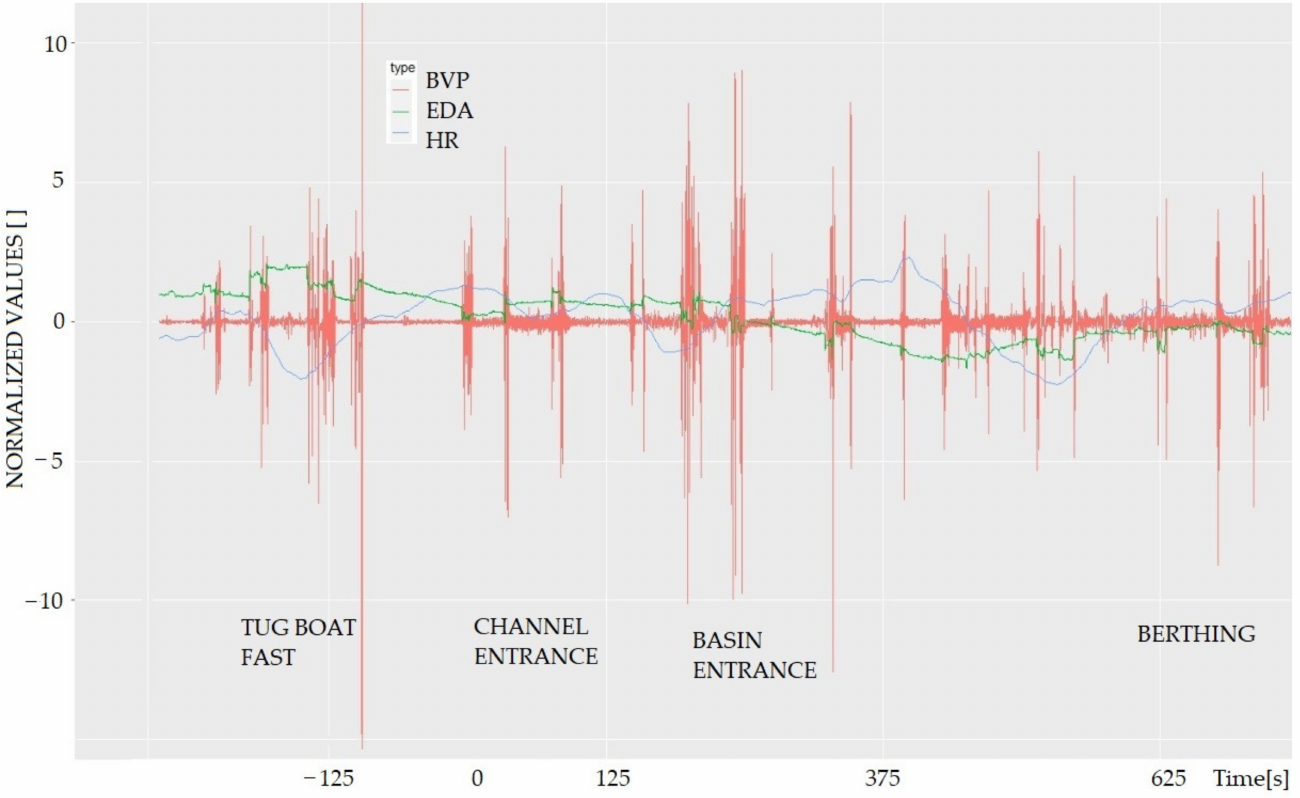
Figure 4. The normalized biometrical response of the experienced participant “1” during the port approaching task. The pattern is similar to all participants. The biometrical intensity typically correlates with situational awareness, given orders, and the ship’s position. Time “zero” is marked at the exact moment when the vessel crosses the line between the buoys at the channel